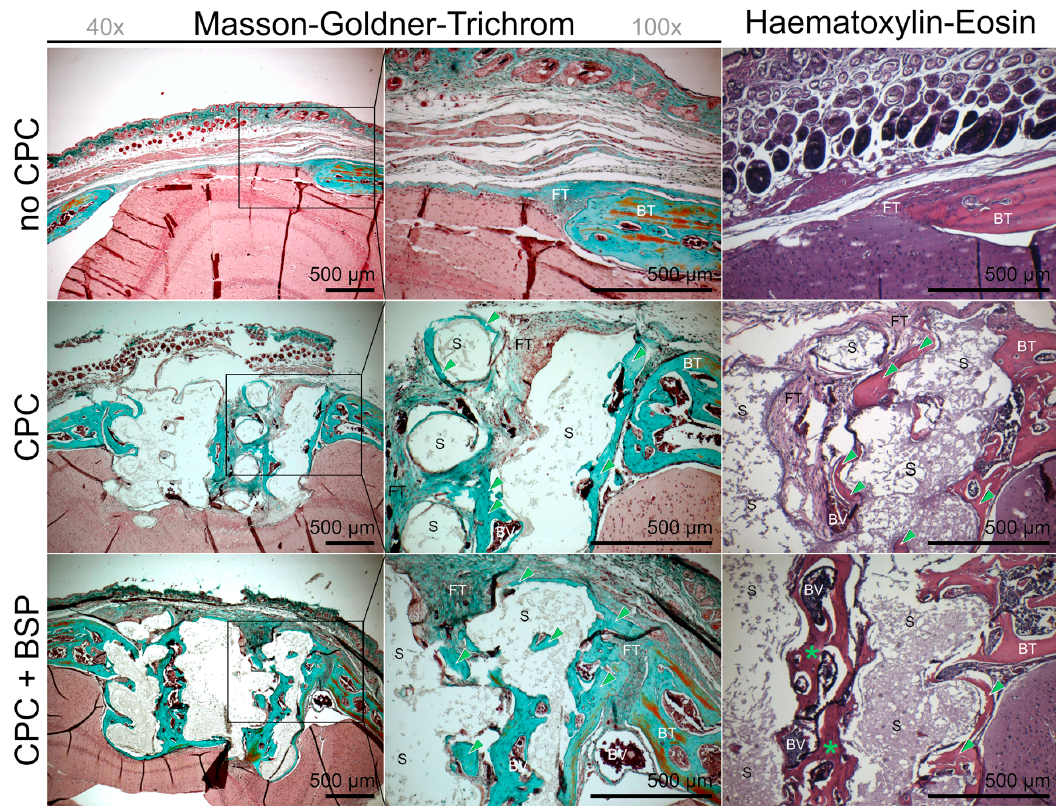
Figure 7. Masson-Goldner-Trichrom (MGT) and hematoxylin-eosin (HE) stainings after eight weeks. New bone growth (green arrows). Trabecular bone structure (green asterisks). BT: calvarial bone tissue at the margins of the defect. BV: blood vessel. FT: fibrous tissue. S: scaffold. BSP-coated scaffolds (CPC + BSP) presented with new bone growth also above and below the